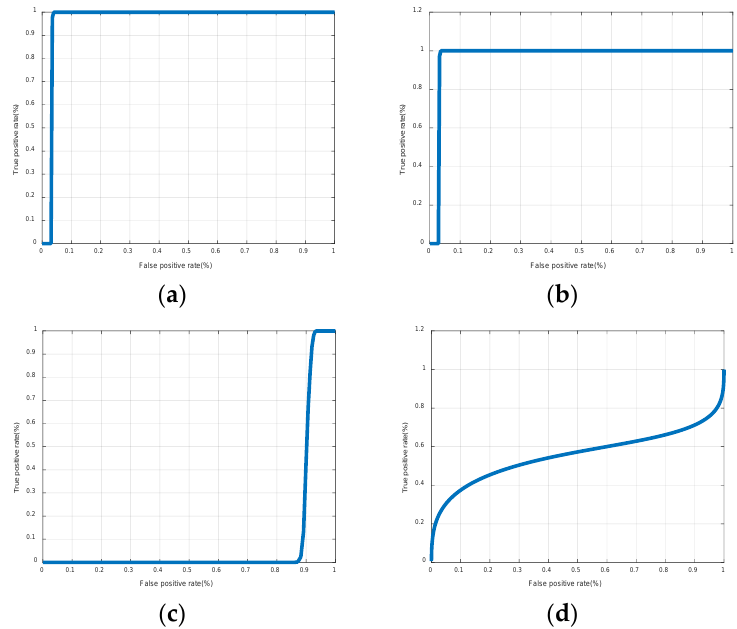
Figure 27. ROC curves for cancellable face recognition frameworks (for LFW dataset) for ( a ) CFR1, ( b ) CFR2, ( c ) homomorphic transform followed by salting and ( d ) homomorphic transform followed by random kernel convolution.